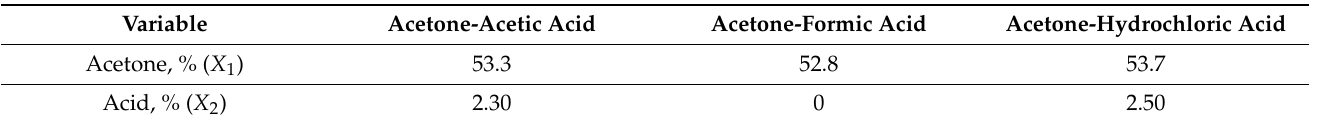
Table 2. Optimized extraction conditions of total procyanidins from American cranberry press residues depending on extraction solvent